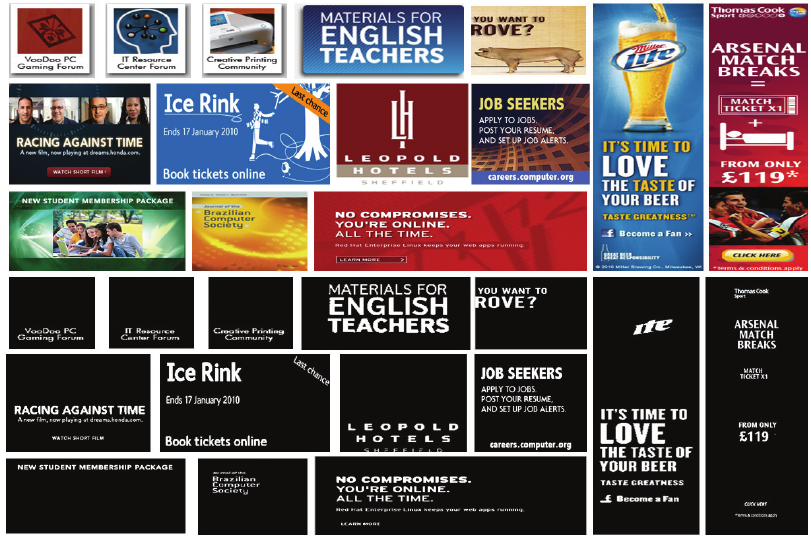
Figure 8: Results on ICDAR2013 dataset method is not the highest performance one.